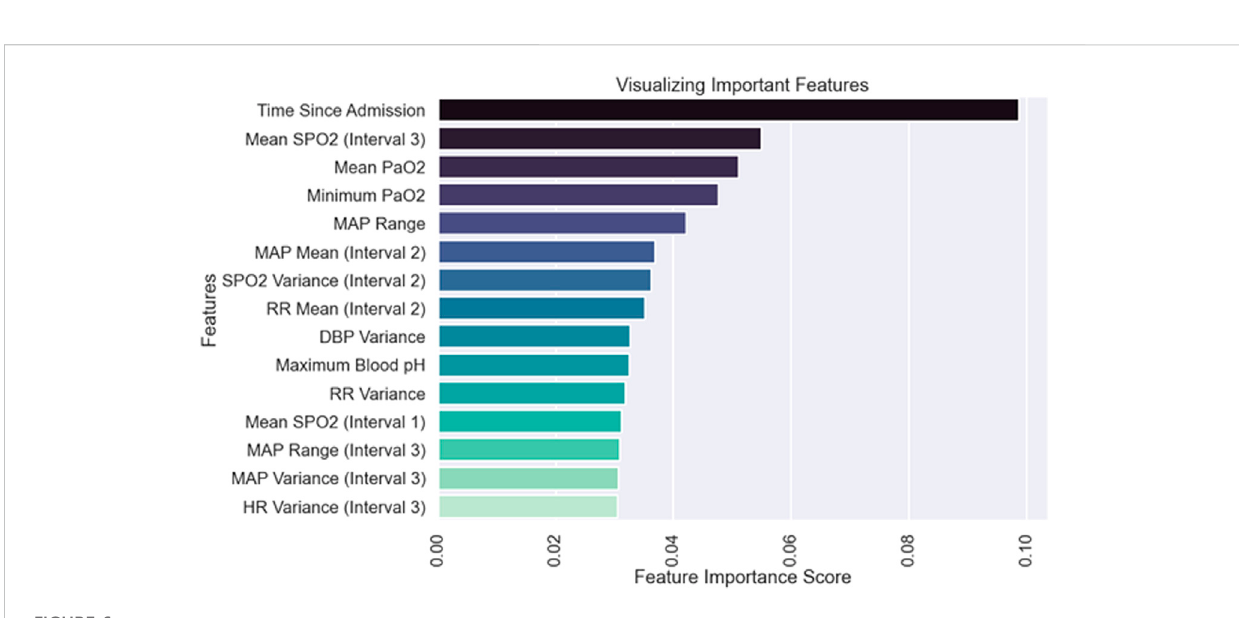
FIGURE 6 Top 15 signi fi cant Features from Cohort 1 manually derived features